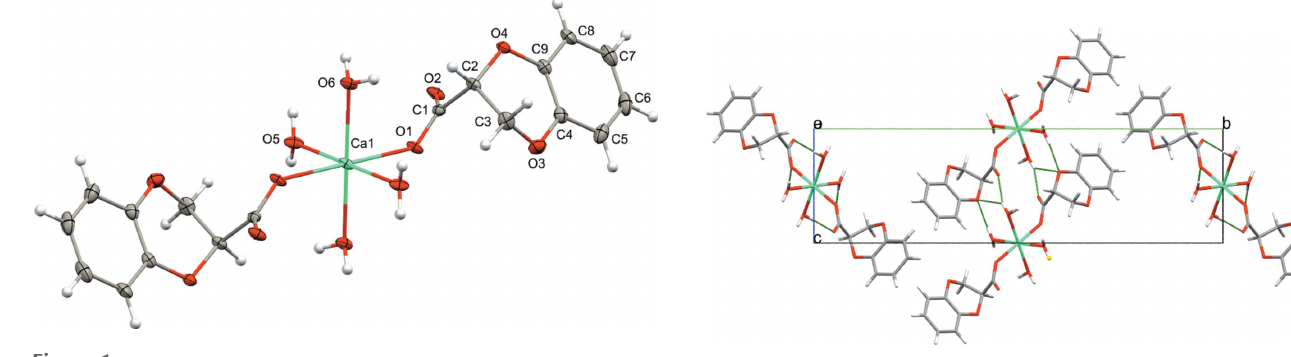
Figure 2 Packing of the molecules of the title compound. O—H (cid:2)(cid:2)(cid:2) O and C— H (cid:2)(cid:2)(cid:2) O hydrogen bonds are shown as green dashed lines.